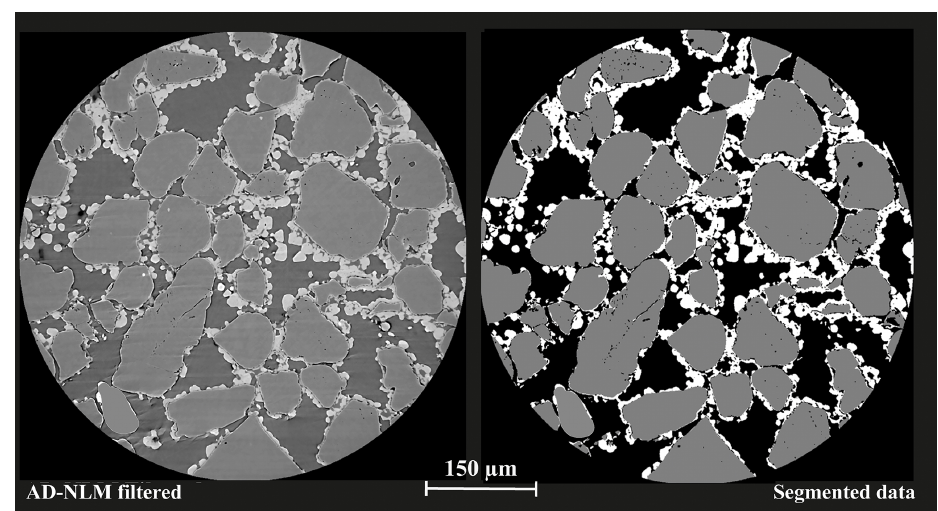
Figure 8. Example on the right is of a successfully segmented dataset. On the left a representative 2-D slice in X–Y direction and the resulting binarized image. Size of the 2-D slice is 2560 × 2560. Black – pore space, grey – quartz and white – hydrate. This segmented data are ready to be utilized as a direct model input.